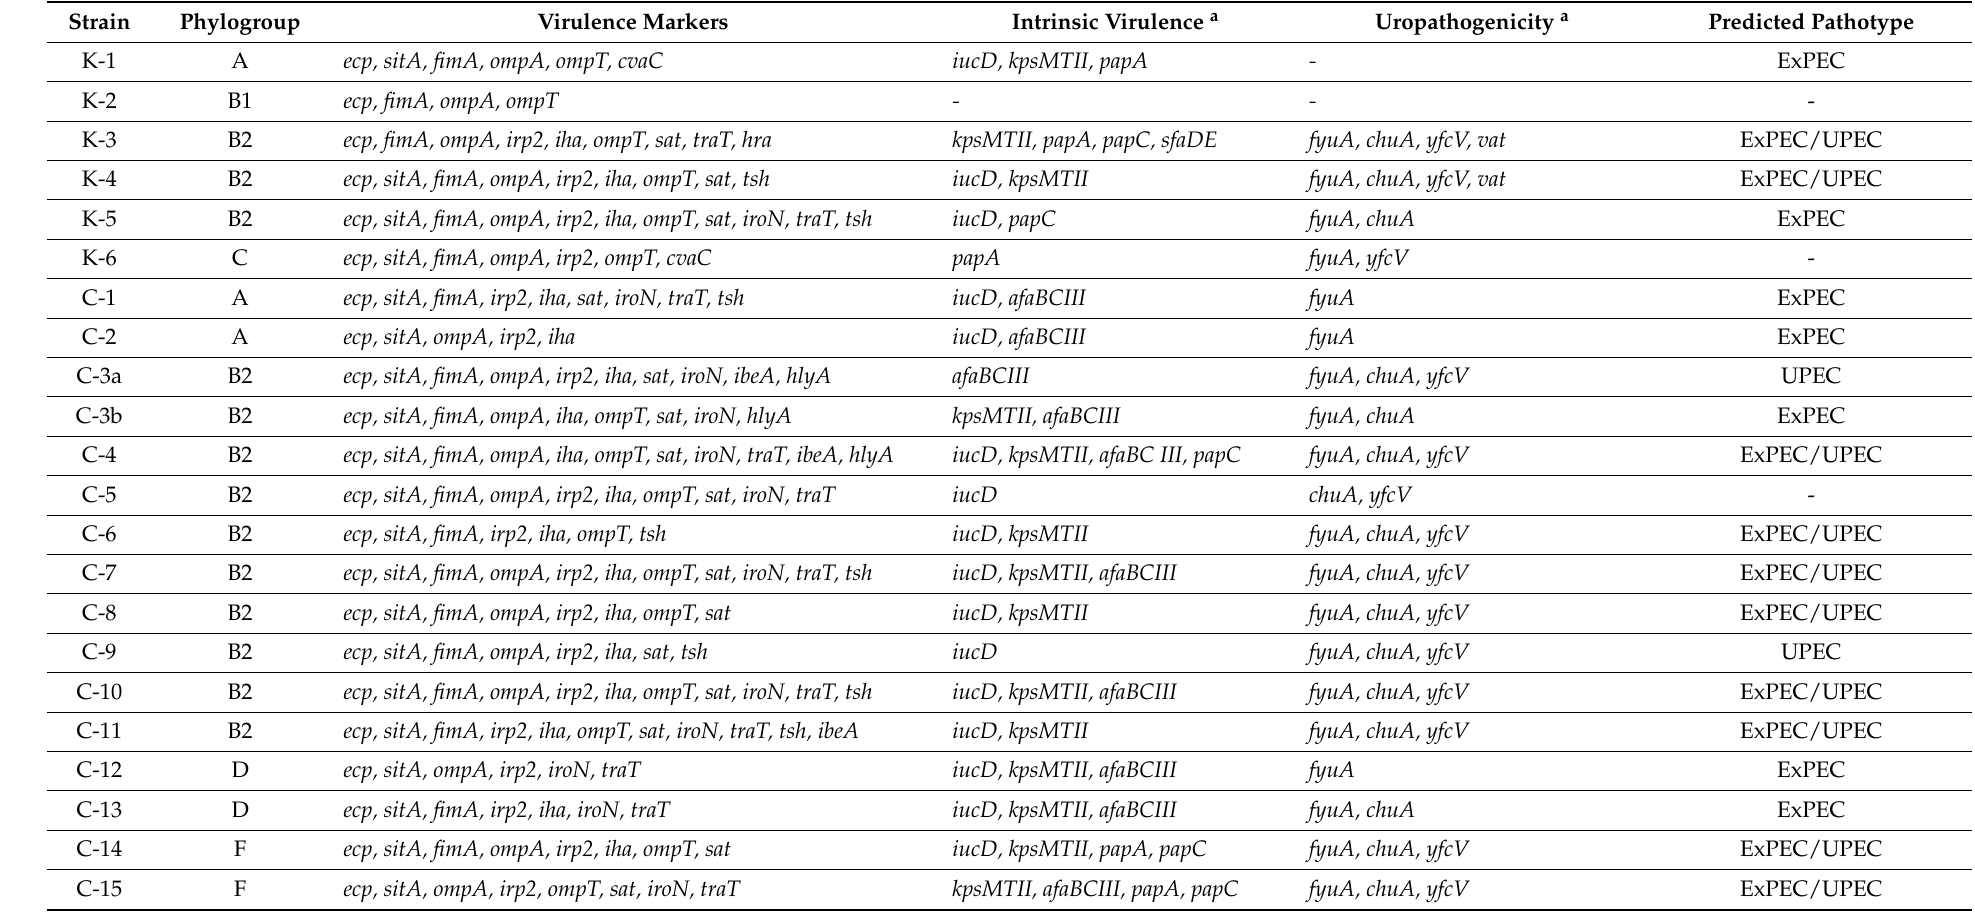
Table 2. Virulence profiles of Escherichia coli strains isolated from eye